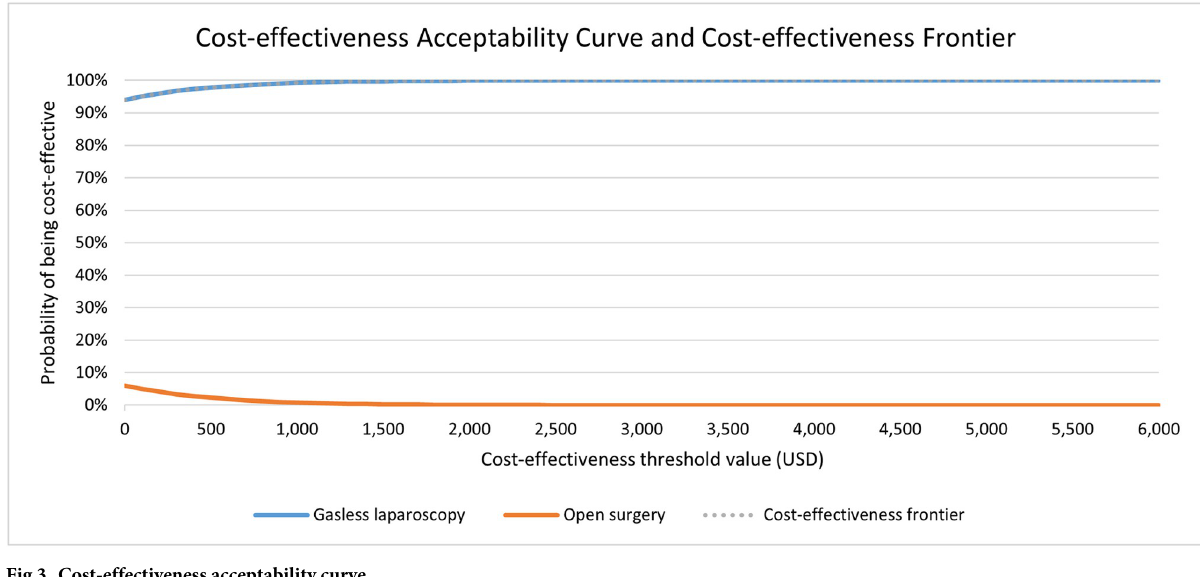
Fig 3. Cost-effectiveness acceptability